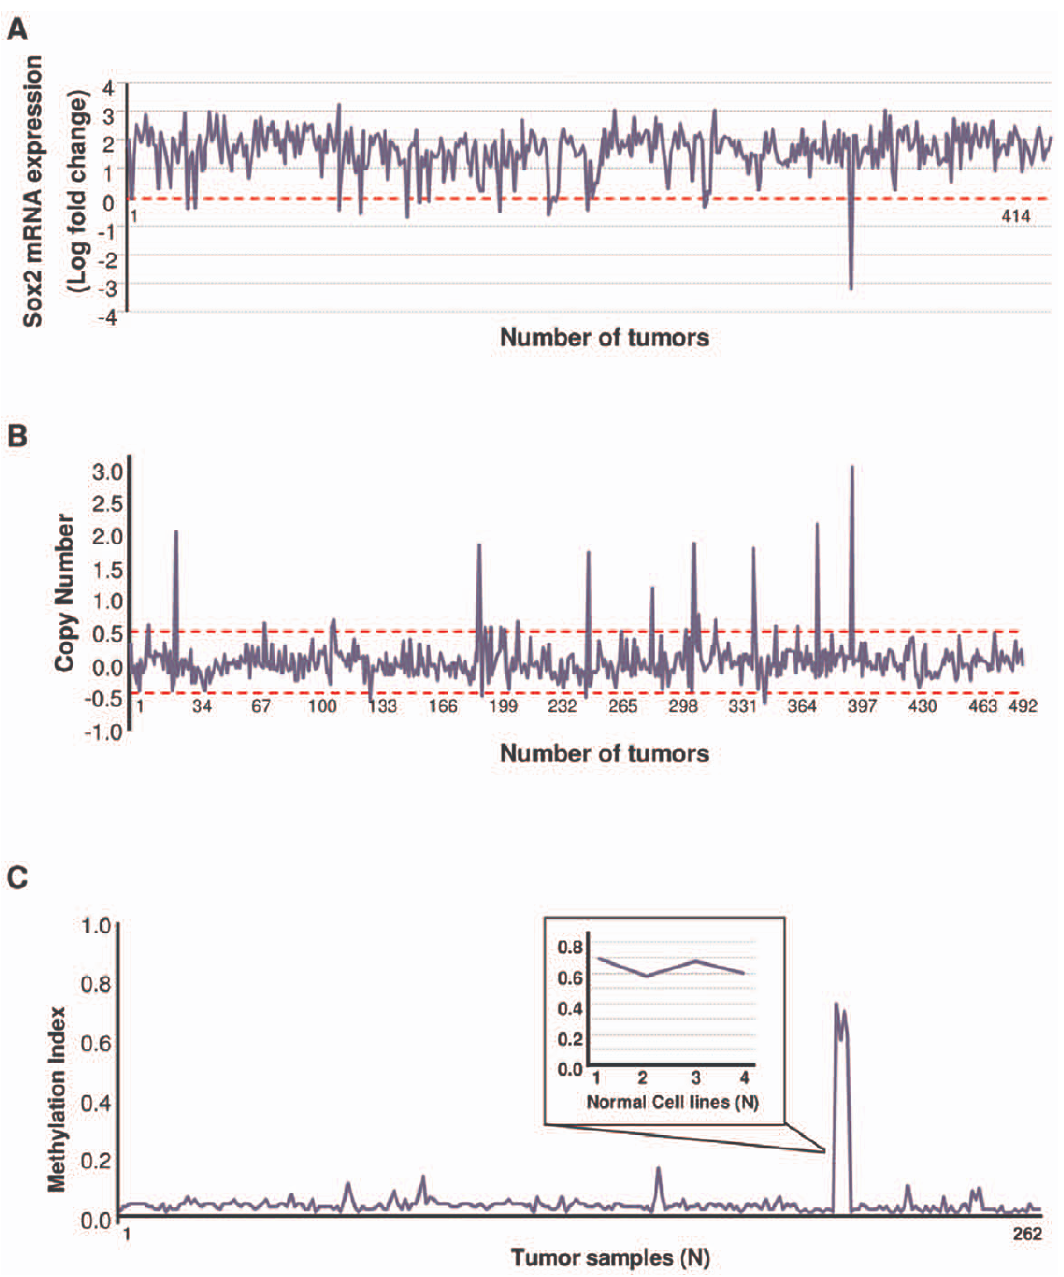
Figure 3. TCGA Data Meta-analysis. A. Relative expression of Sox2 mRNA in 414 GBM samples from TCGA. Sox2 was overexpressed in 86% of the samples (357/414). The red dashed lines represent the normal threshold. B. Amplification of the Sox2 locus in 492 GBM specimens from TCGA. Sox2 showed amplification in the number of copies (copy number $ 2.5 copies) in 8.5% of the samples (42/492). The red dashed lines represent the normal copy number. C. Sox2 methylation status of 262 samples (258 tumors and 4 normal cell lines). These data show that Sox2 is methylated in the normal cell lines and hypomethylated in 100% of the tumor samples.